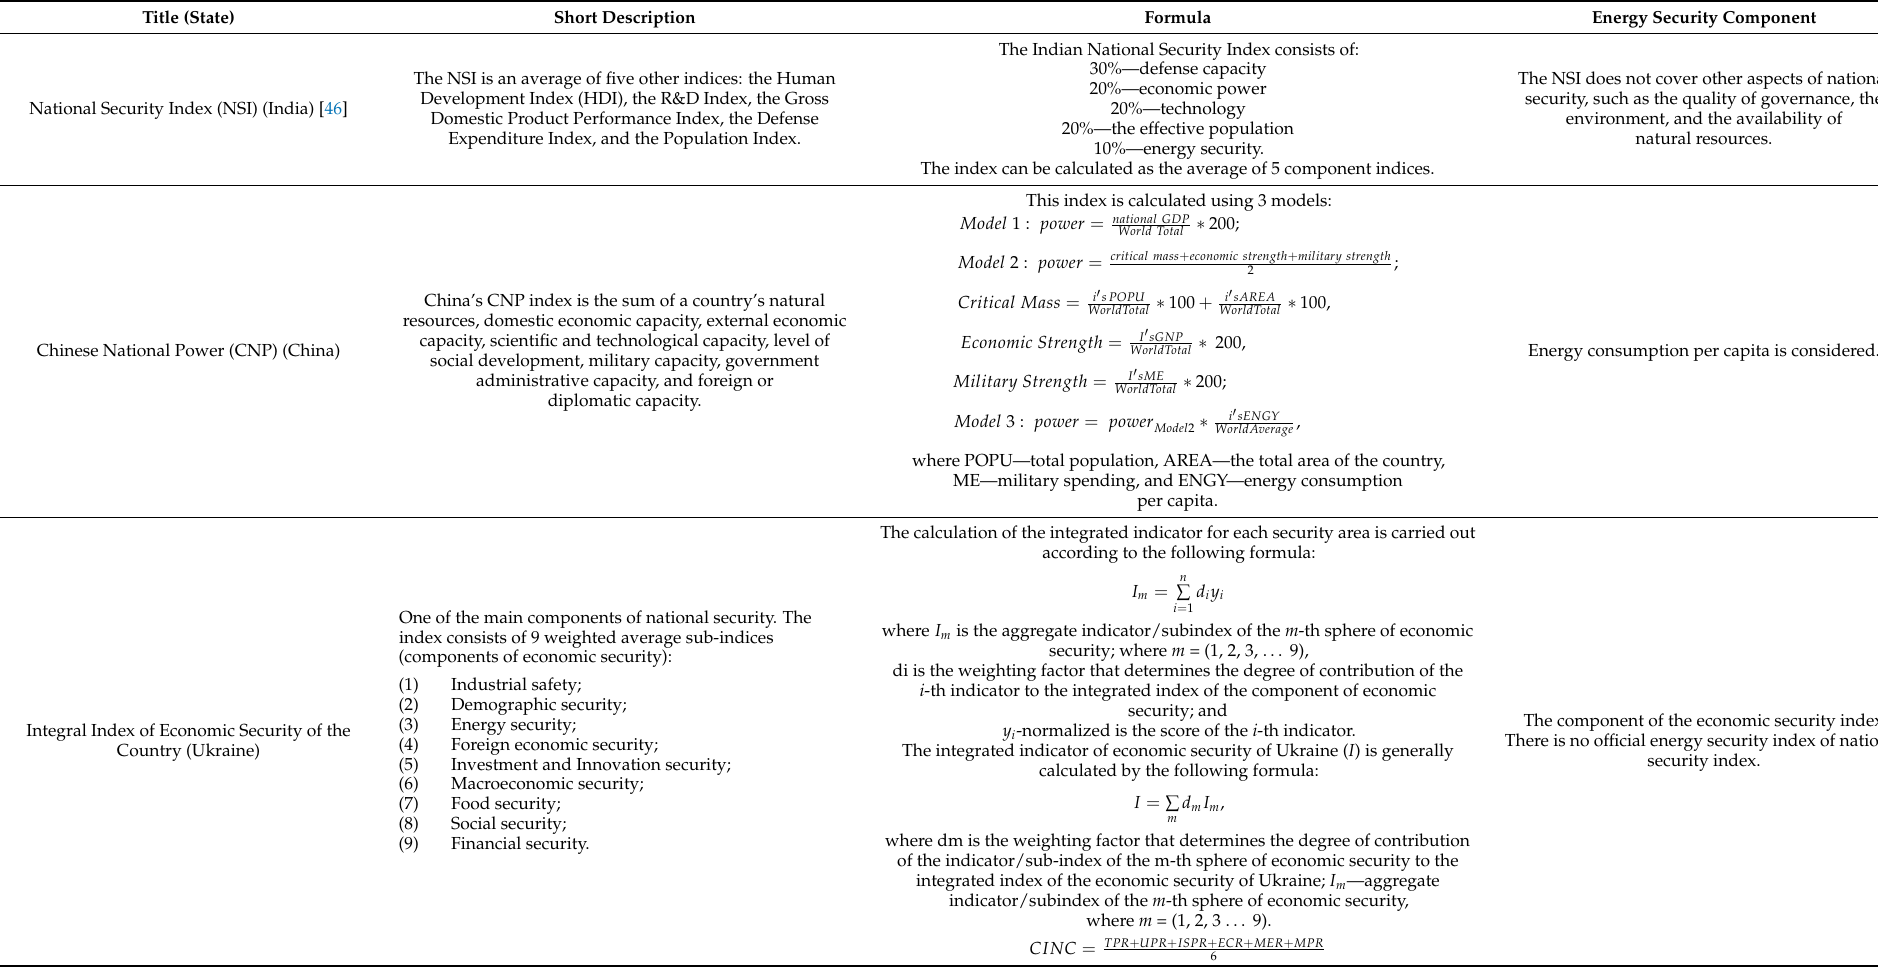
Table 1. World indexes of national